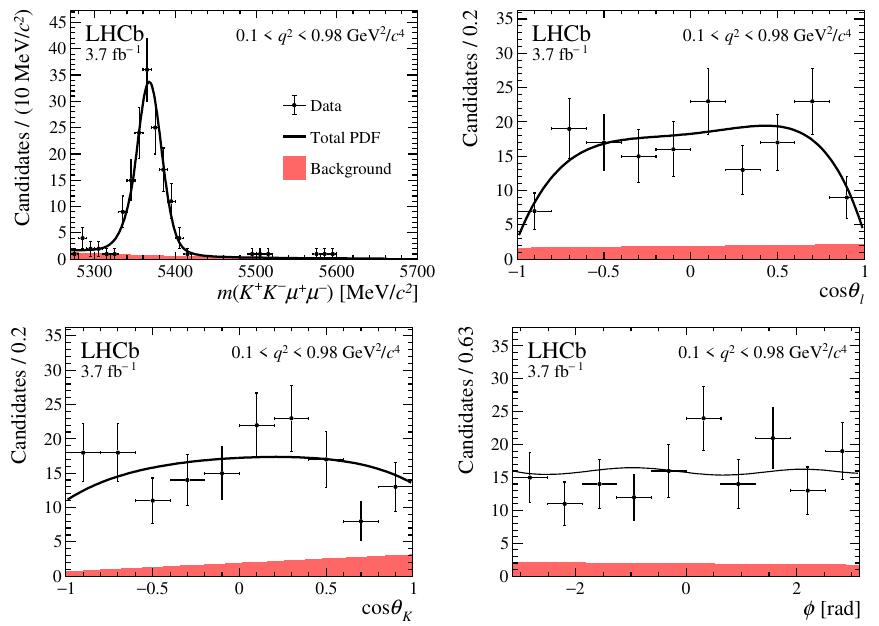
Figure 14 . Mass and angular distributions of B 0 0 . 1 < q 2 < 0 . 98 GeV 2 /c 4 for data taken in 2017–2018. The data are overlaid with the projections of the fitted PDF.